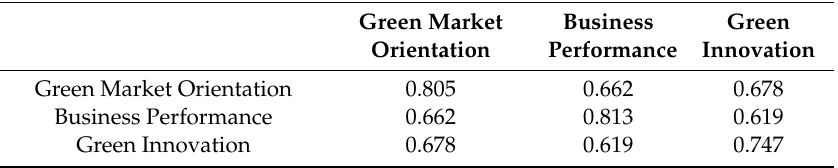
Table 4. Discriminant